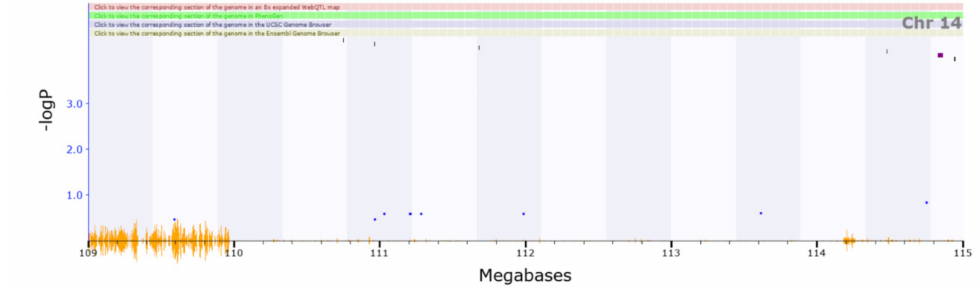
Figure 6. There is a single gene with a cis-eQTL corresponding to the QTL region on chromosome 14. Slitrk6 (109.23 Mb), loss of this gene in mice has been associated with impaired locomotory behavior as well as altered responses to novel environmental